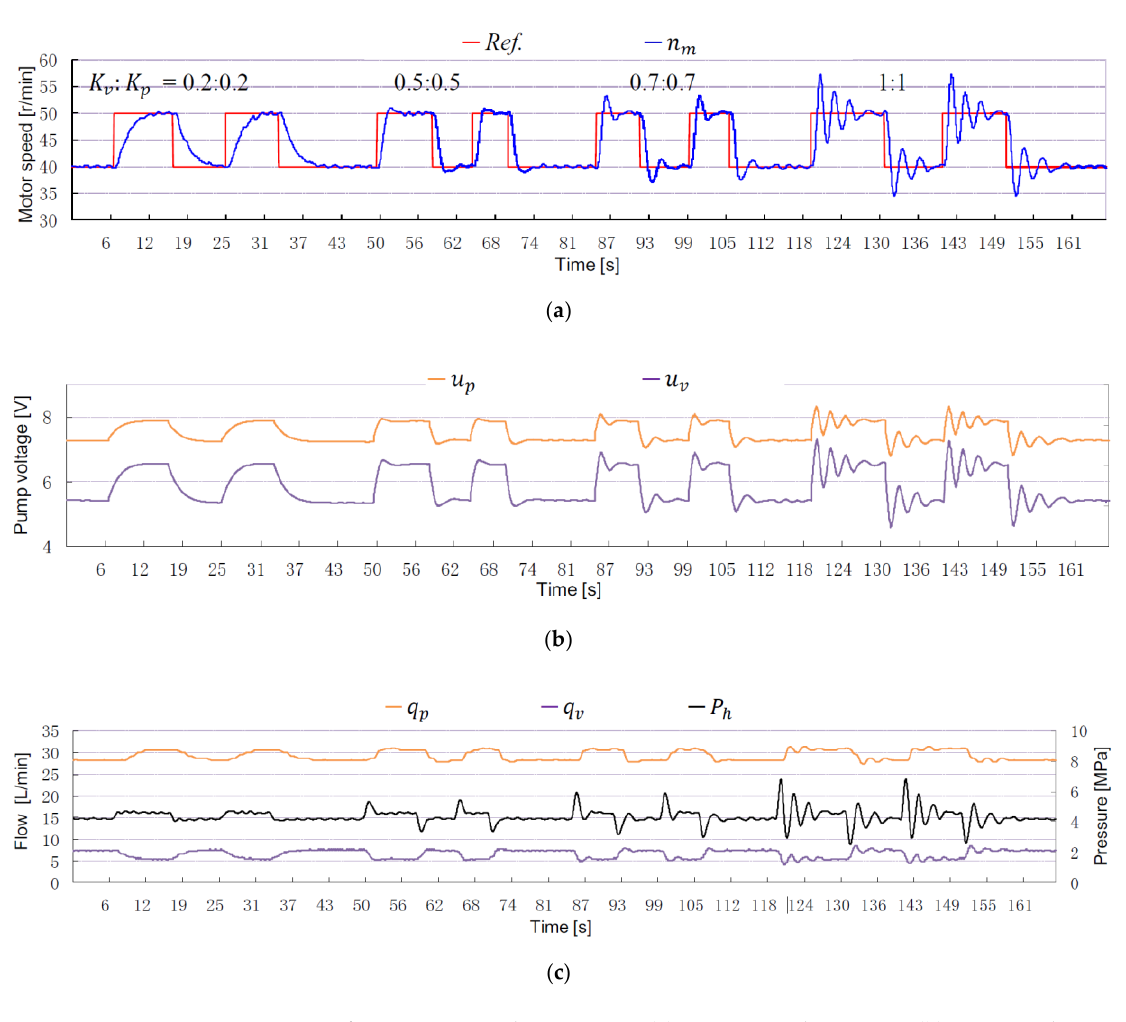
Figure 8. Step response to reference inputs when K vp = 1. ( a ) Motor speed response; ( b ) Pump and valve voltage variation; ( c ) System pressure and flow response.